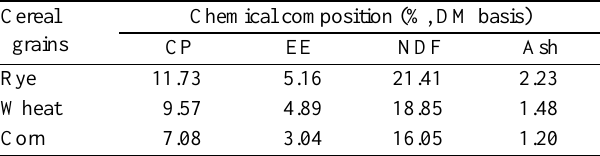
Table 1. Chemical composition of cereal grains added to the culture solutions (%, DM basis) Cereal